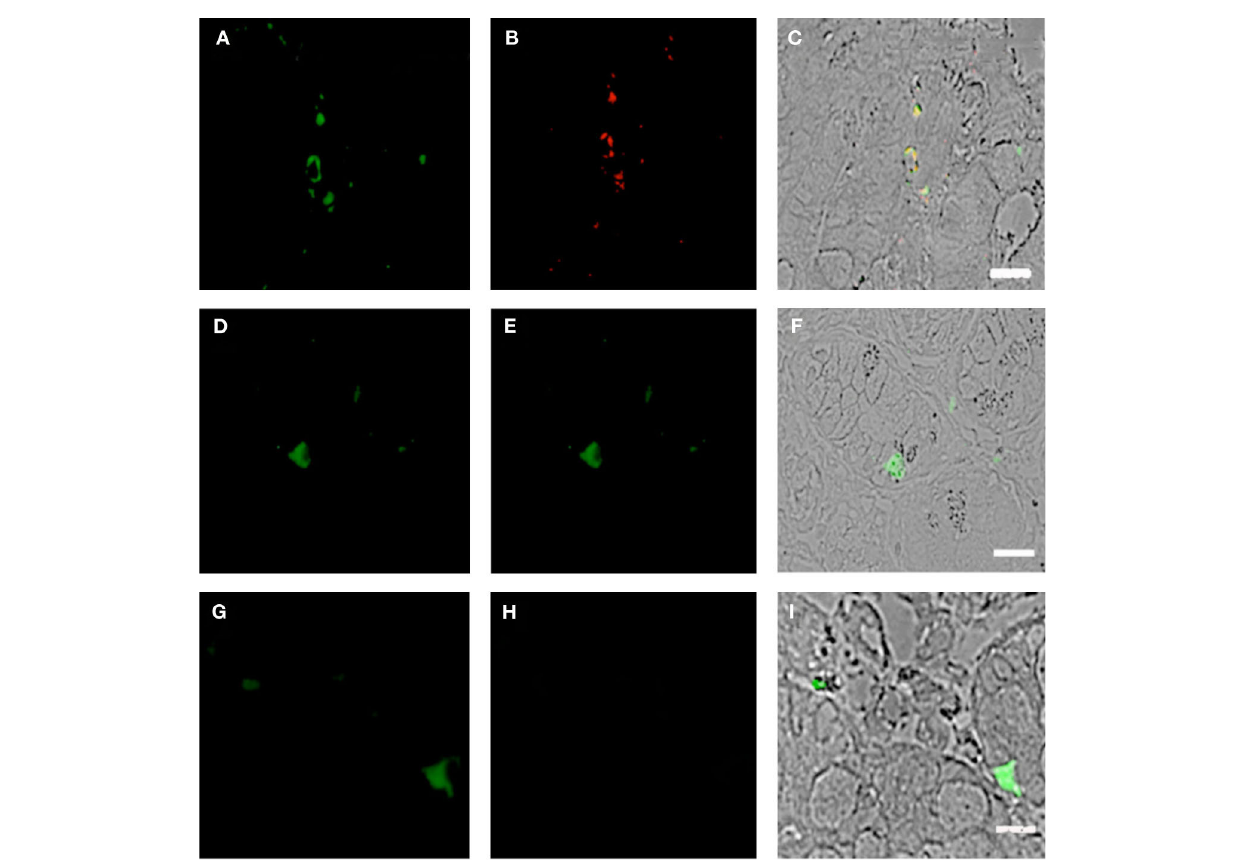
FigUre 7 | Duodenum biopsies of hiV/aiDs cases and controls evaluated for coexpression of cD303 (green) and granzyme B (gZMB) (red) . Bar represents 20 μ m. (a) HIV case duodenum biopsies probed with a monoclonal FITC-anti-CD303 antibody. (B) HIV case duodenum biopsies probed with monoclonal APC-anti-GZMB antibody. (c) HIV case duodenum biopsies DIC image merged with (a,B) . (D) Control duodenum biopsies probed with monoclonal FITC-anti-CD303 antibody. (e) Control duodenum biopsies probed with monoclonal APC-anti-GZMB antibody. (F) Control duodenum biopsies DIC image merged with (D,e) . (g) HIV case duodenum biopsies probed with a monoclonal FITC-anti-CD303 antibody. (h) HIV case duodenum biopsies probed with a PE-Mouse IgG1 isotype control antibody. (i) HIV case duodenum biopsies DIC image merged with (g,h)